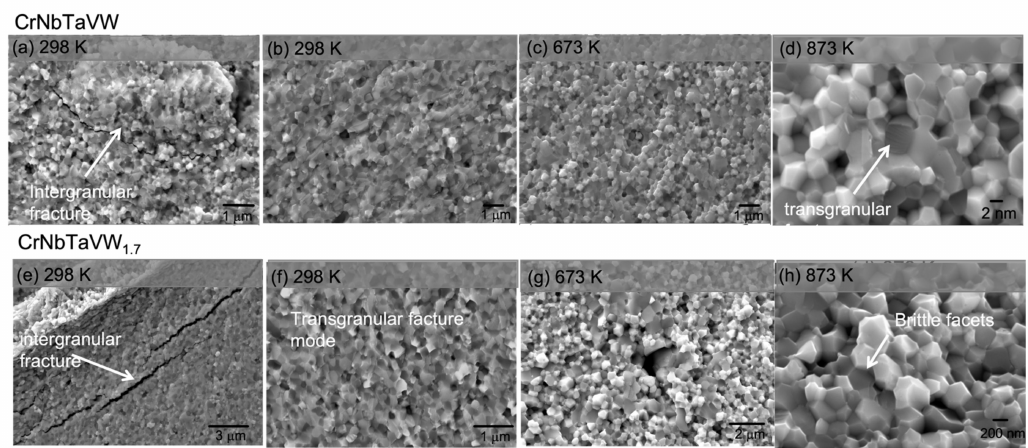
Figure 5. Types of fracture and cleavage facets observed throughout the three test temperatures for CrNbTaVW at ( a ) and ( b ) 298 K, ( c ) 673 K and ( d ) 873 K and for CrNbTaVW 1.7 at at ( e ) and ( f ) 298 K, ( g ) 673 K and ( h ) 873